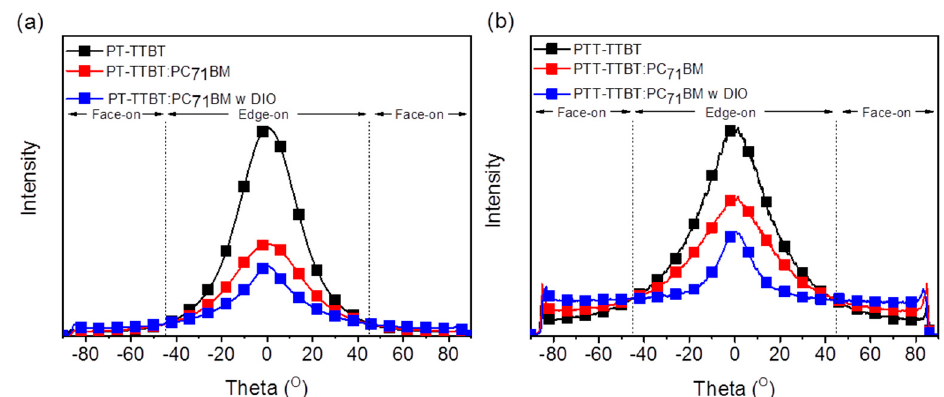
Figure 5. Azimuthal angle scan profiles for the neat polymer and blended films at the (100) peak for ( a ) PT-TTBT and ( b ) PTT-TTBT .